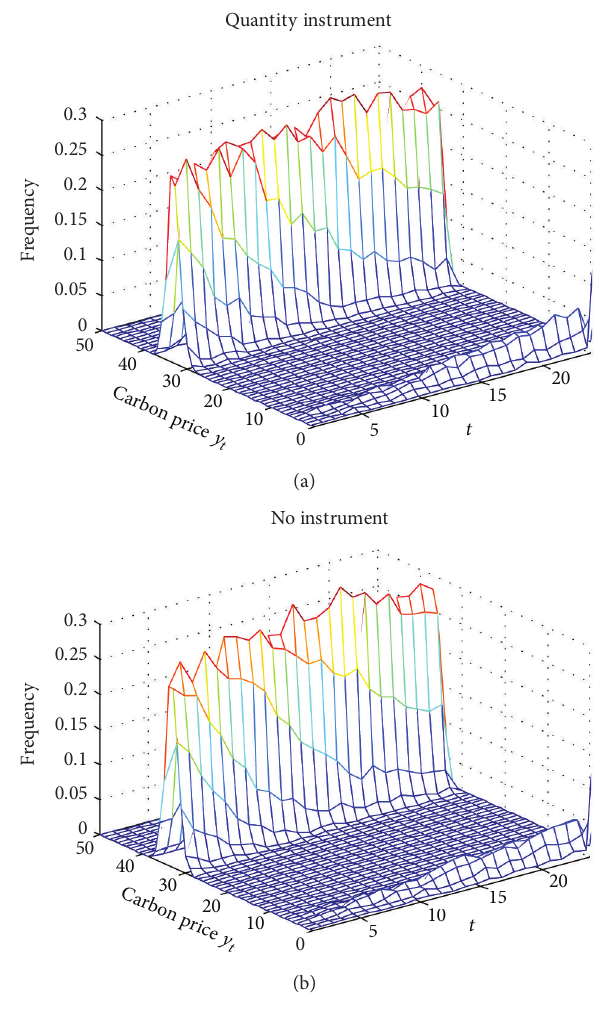
Figure 1: Carbon price frequency distribution diagram of upper threshold regulation using quantity